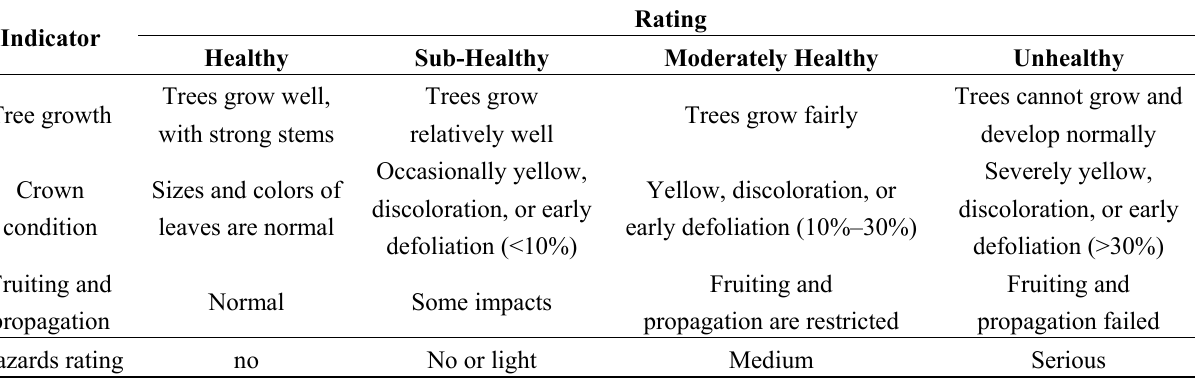
Table 1. Indicators and ratings for evaluating the health of forest ecosystems in China [20].